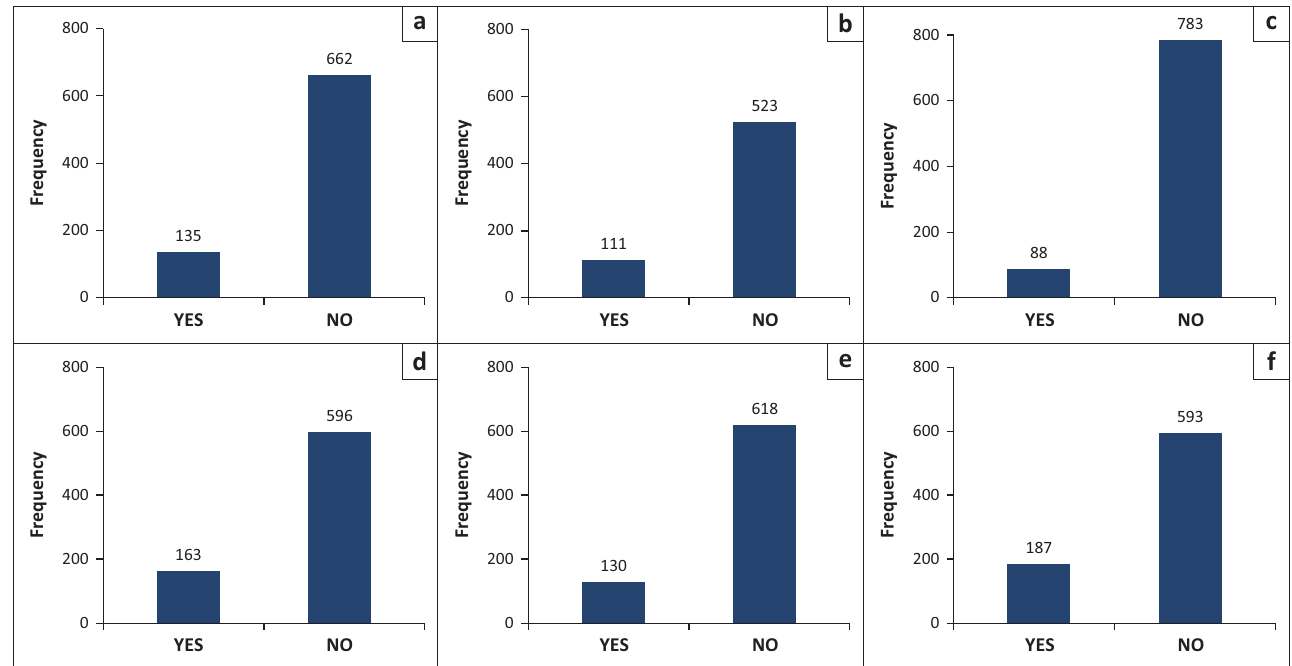
FIGURE 1: Graphical representation of propensity score